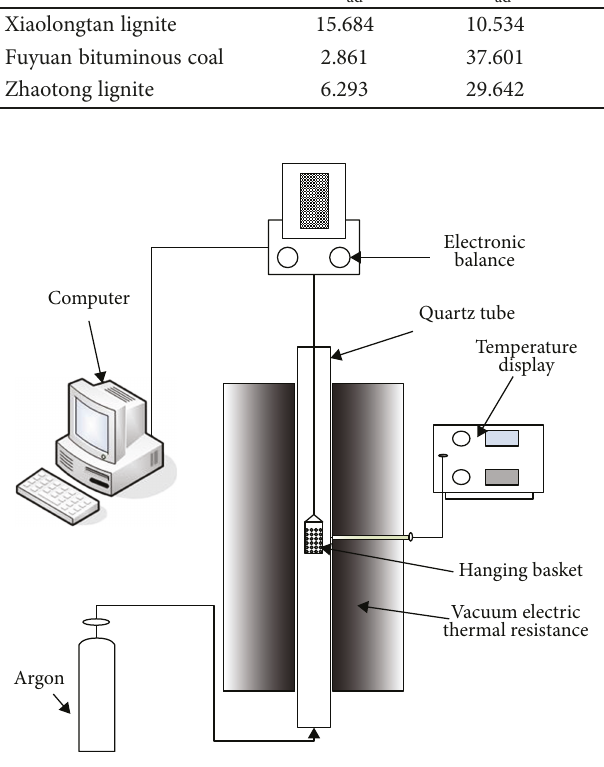
Figure 2: Blending coal combustion characteristics experimental equipment